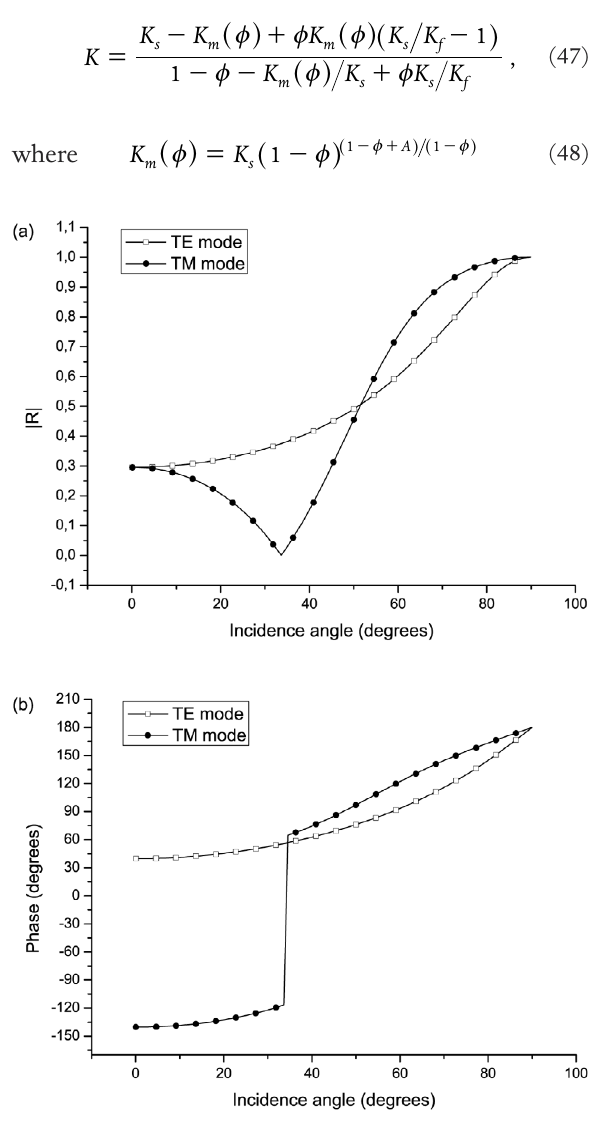
Figure 8. Absolute value (a) and phase (b) of the TE- and TM-wave reflection coefficients as a function of the incidence angle at f = 100 MHz and h = 20 cm.